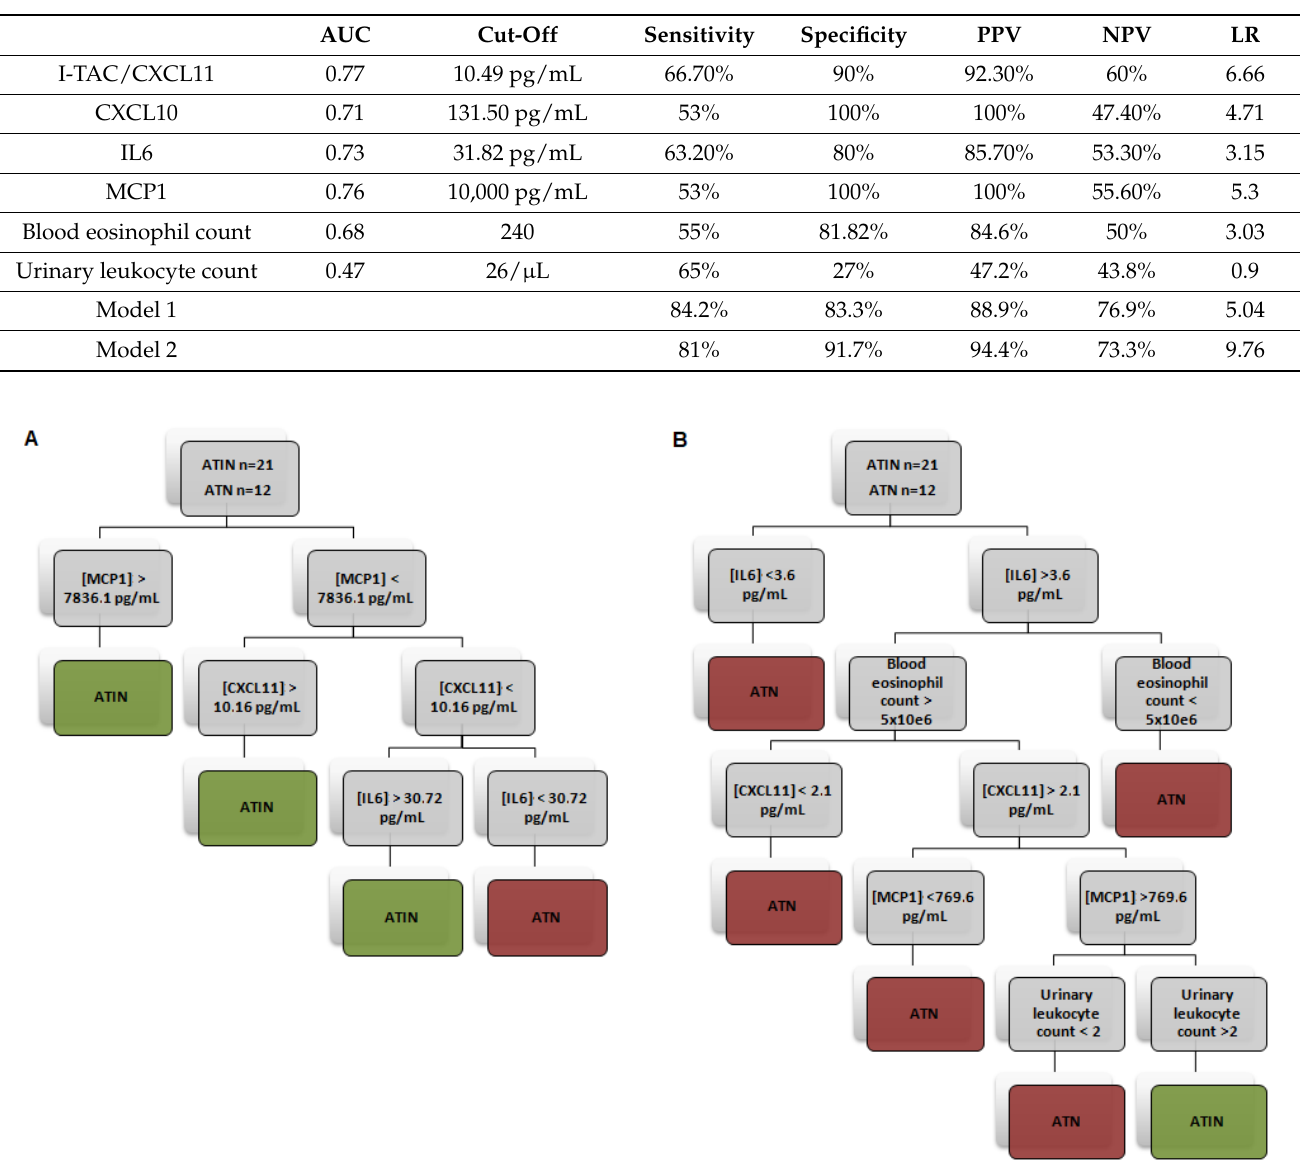
Figure 3. Decision trees elaborated by recursive partitioning combining different classical and novel biomarkers of acute tubulointerstitial nephritis. Model 1 ( A ) includes urinary CXCL11, MCP-1 and IL6 levels. Model 2 ( B ) combines urinary level of these cytokines with urinary leukocyte and blood eosinophil counts. ATIN—acute tubulointerstitial nephirits, ATN—acute tubular necrosis